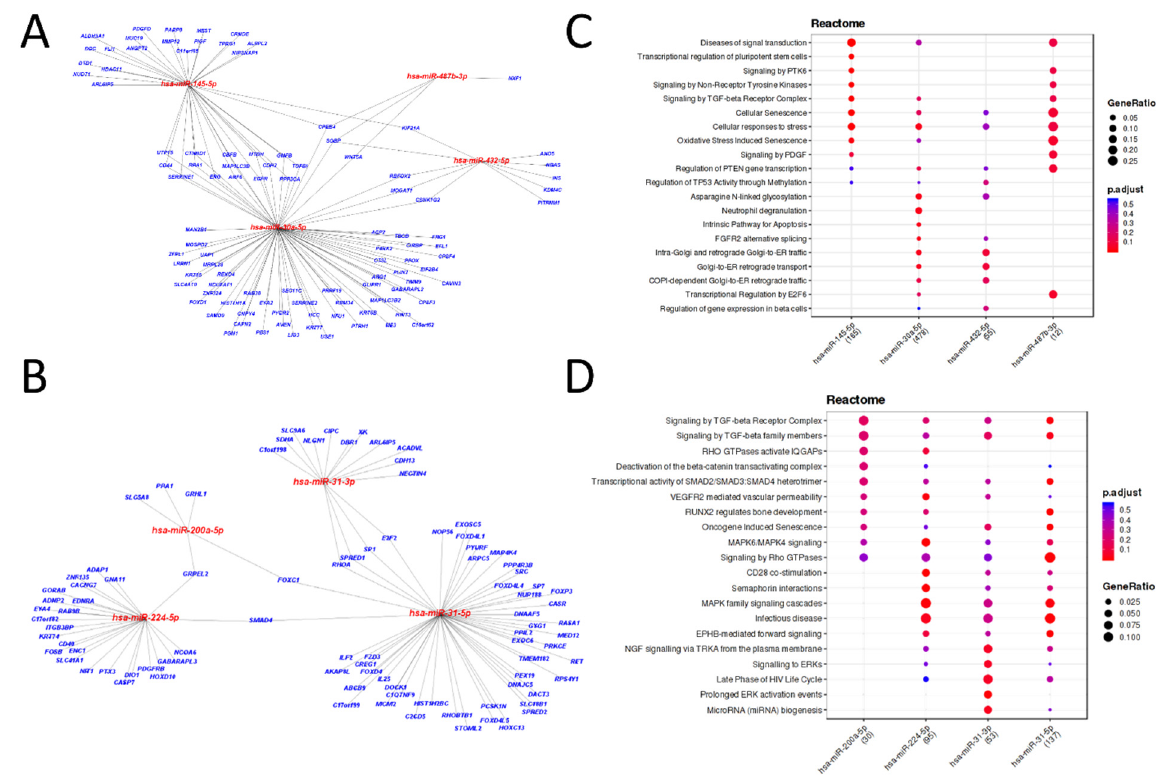
Figure 2. Experimentally validated targets of differentially expressed miRNAs (DEmiRs) of the comparison between tumoral x non-neoplastic tissues. ( A , B ) The miRTarBase 8.0 database supported information for networks representing miRNA and their experimentally validated target genes with weak and strong evidence levels for downregulated ( A ) or upregulated ( B ) DEmiRs; ( C , D ) Enrichment plots of Reactome pathways for experimentally validated miRNA targets with weak and strong evidence levels for downregulated ( C ) or upregulated ( D ) DEmiRs obtained from the Mienturnet tool. Each enrichment plot includes dots indicating miRNAs whose targets participate in the corresponding pathway. These dots are colored by p -adjusted value and sized by the gene ratio per pathway. Table 4. DEGs detected in the comparison of tumor tissues ( n = 24) and non-neoplastic tissues ( n = 24) of PeC patients by qRT-PCR.